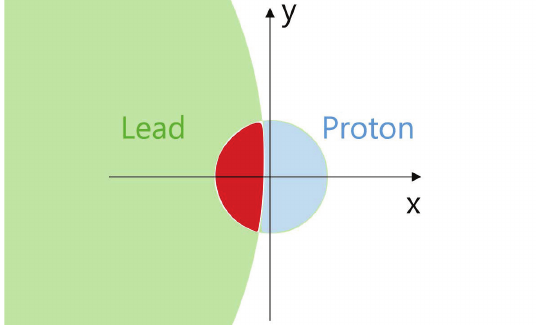
Figure 15. Overlap (red) of the thickness functions in the transverse plane for lead (green) and proton (blue). (From Dinh, MSc thesis HD 2019, unpublished. Reproduced with permission.)